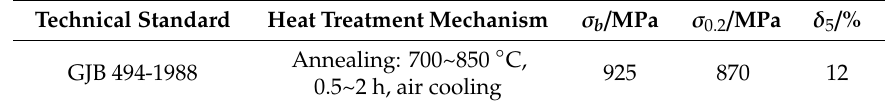
Table 3. Heat treatment mechanism and basic mechanical properties of Ti6Al4V titanium alloy (Data from [23]).